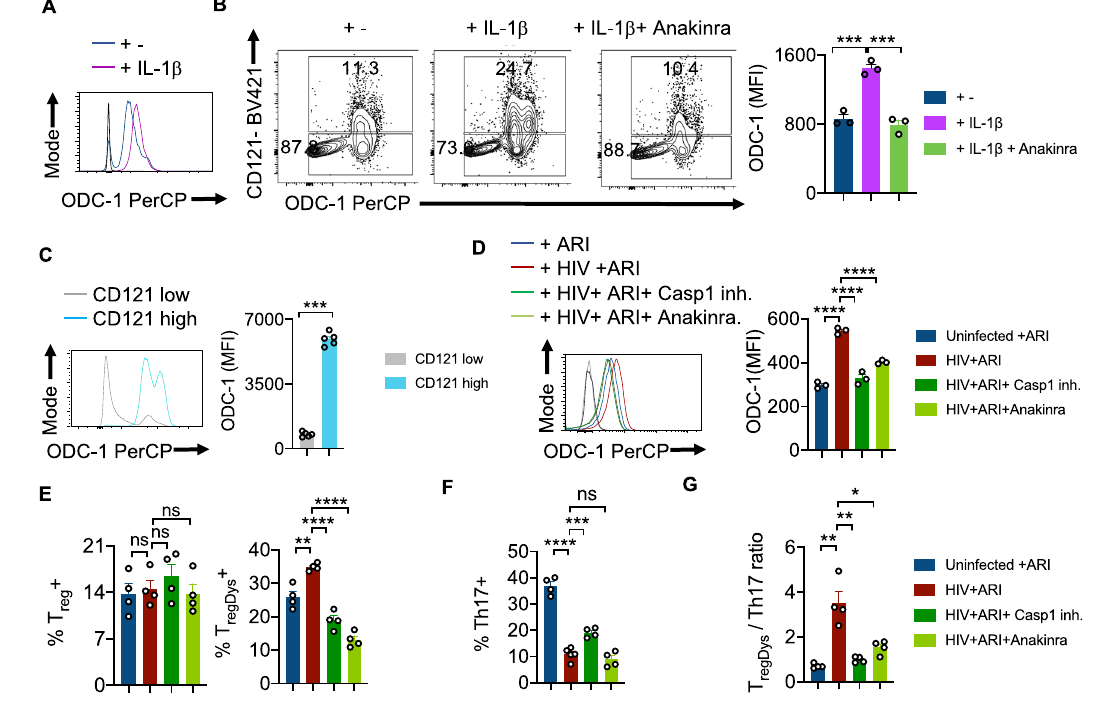
Fig.4|HIV-1activatedcaspase-1andIL-1 β arerequiredforODC-1expressionin CD4 + Tcells. HTOCcellswereTCRstimulatedwithIL-1 β